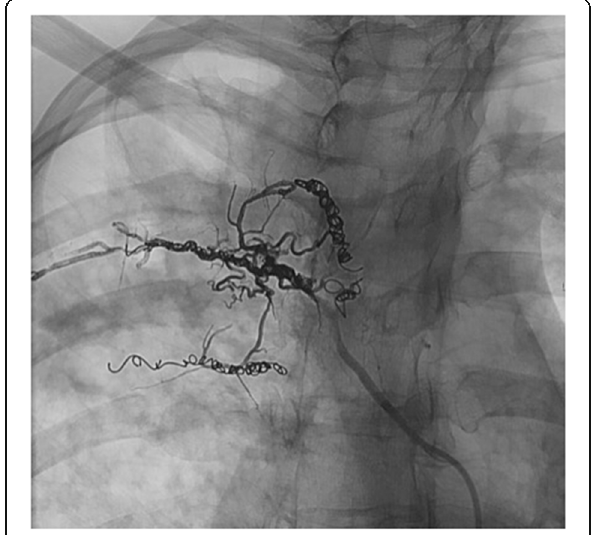
Fig. 5 Superselective slight RAO postembolization arteriography demonstrated no residual flow to the diseased portion of the lung from the targeted feeding